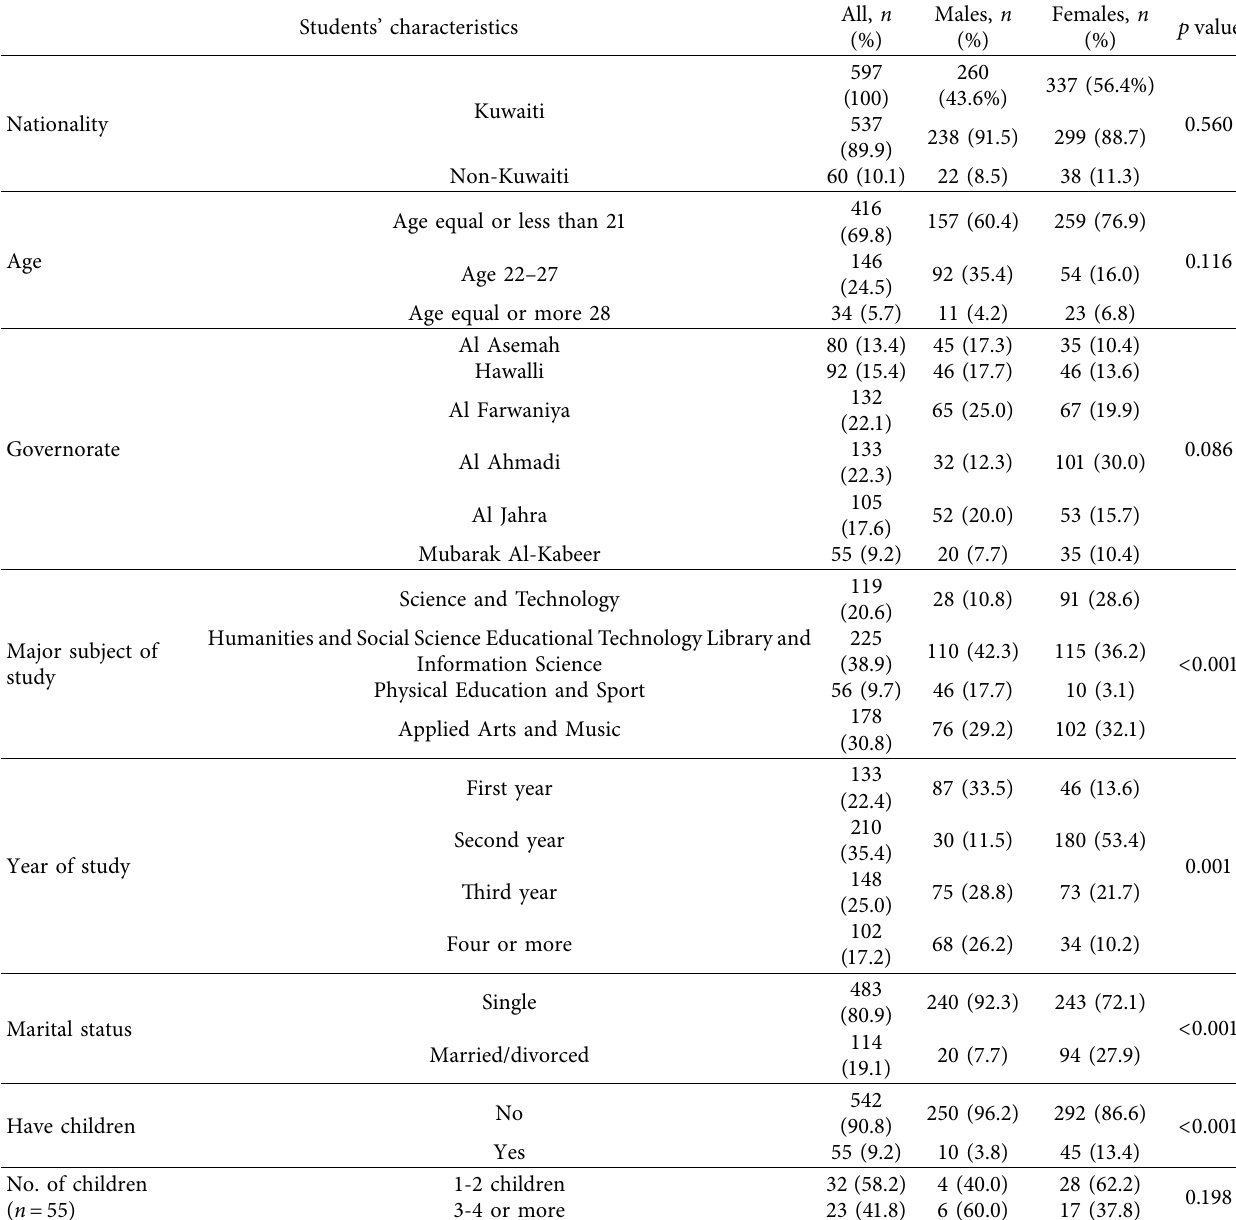
Table 2: Sociodemographic characteristics of the study